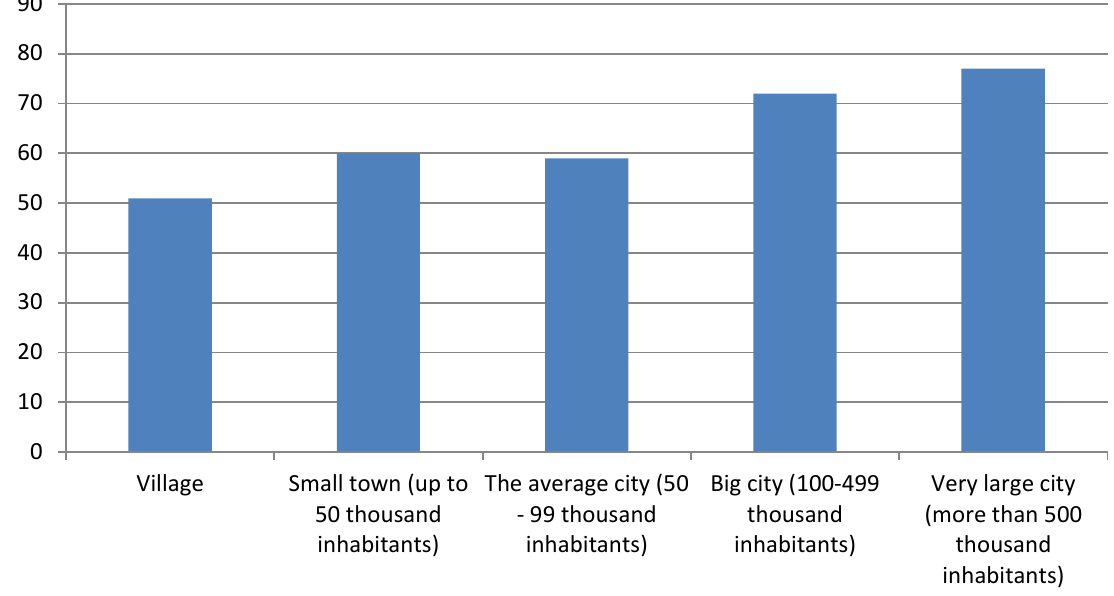
Figure 2. Share of Internet users among inhabitants of settlements of different types, %